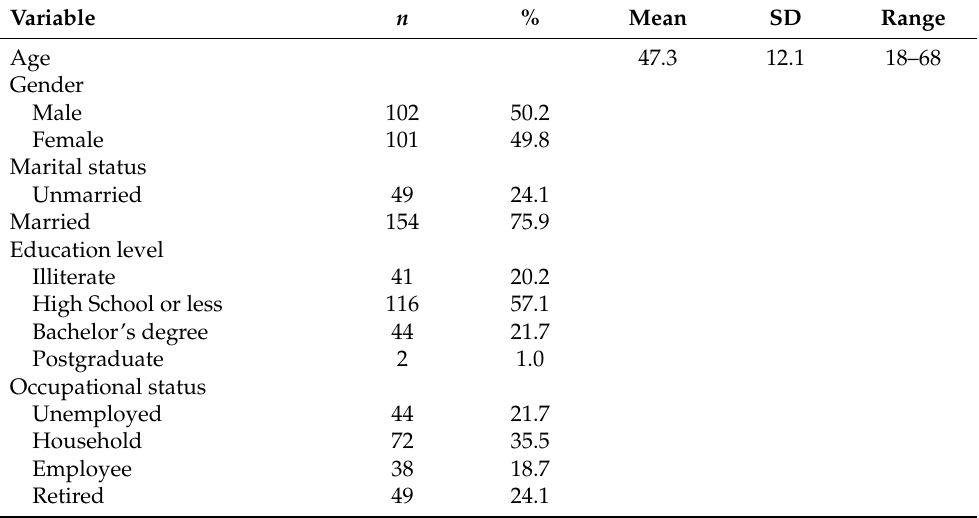
Table 1. Characteristics of the study population, n =